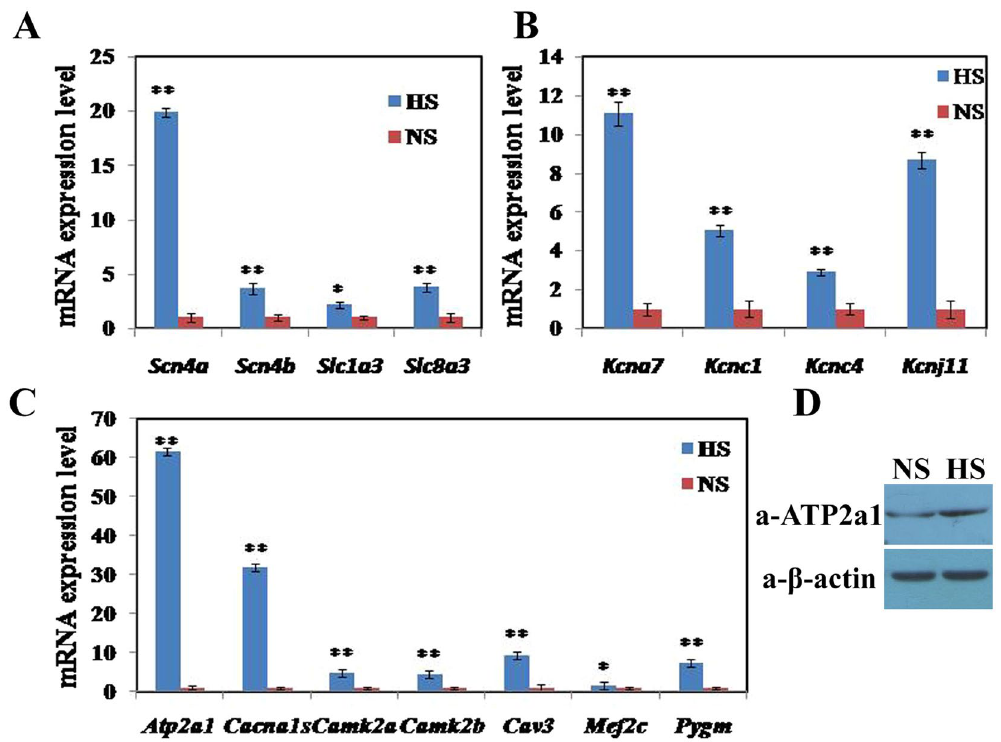
Figure 7. Up-regulated expression of genes related to sodium, potassium and calcium ion metabolism, and protein level of ATP2a1 in adipose tissue after mice were fed for 8 wk with HS. ( A ) mRNA levels of genes related to sodium ion metabolism were up-regulated. ( B ) mRNA levels of genes related to potassium ion metabolism were up-regulated. ( C ) mRNA levels of some genes related to calcium ion and lipid metabolism were up-regulated. ( D ) The protein content of ATP2a1 was increased. Data are means ± SEM, n = 3. * P < 0.05; ** P <